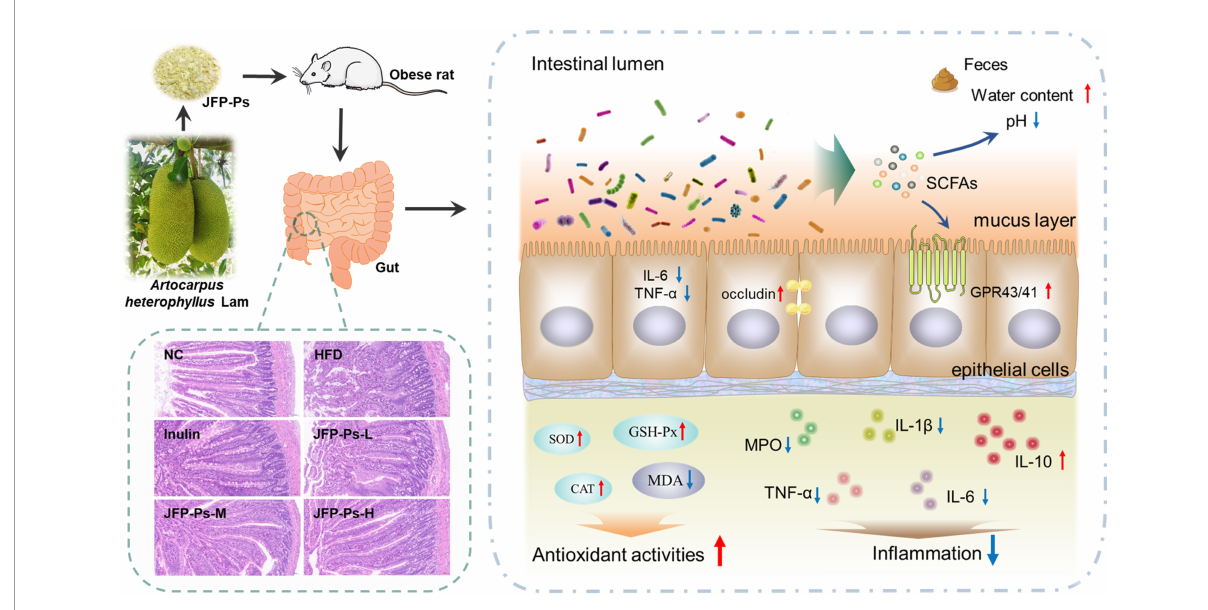
FIGURE5 The beneficial effects of JFP-Ps on intestinal barrier function in high fat diet-induced obese